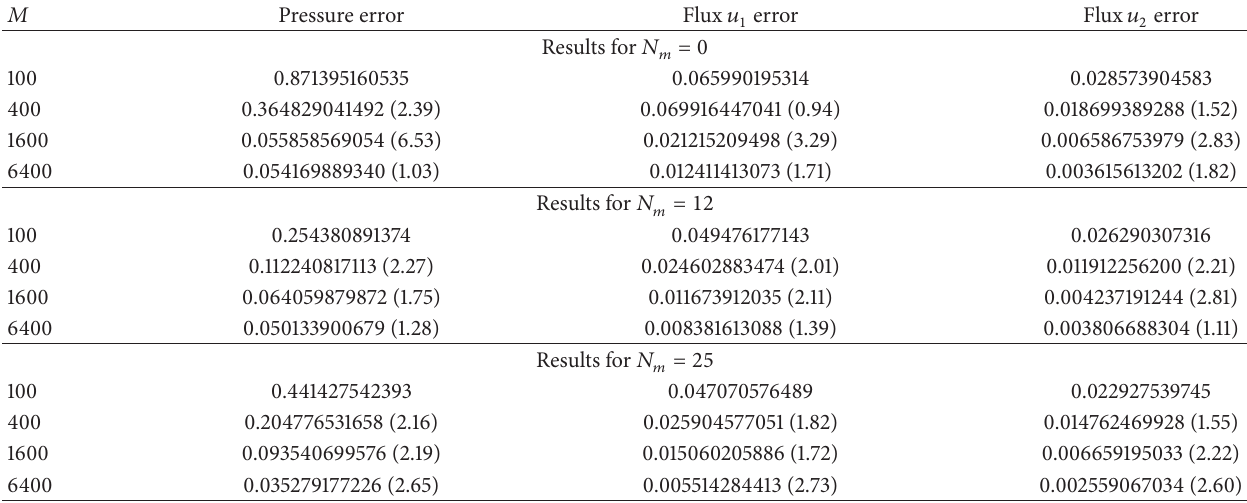
Table 1: Stochastic convergence results for KL-MC simulations with 𝑀 max = 25600 in the pressures and fluxes. Convergence ratios are given in